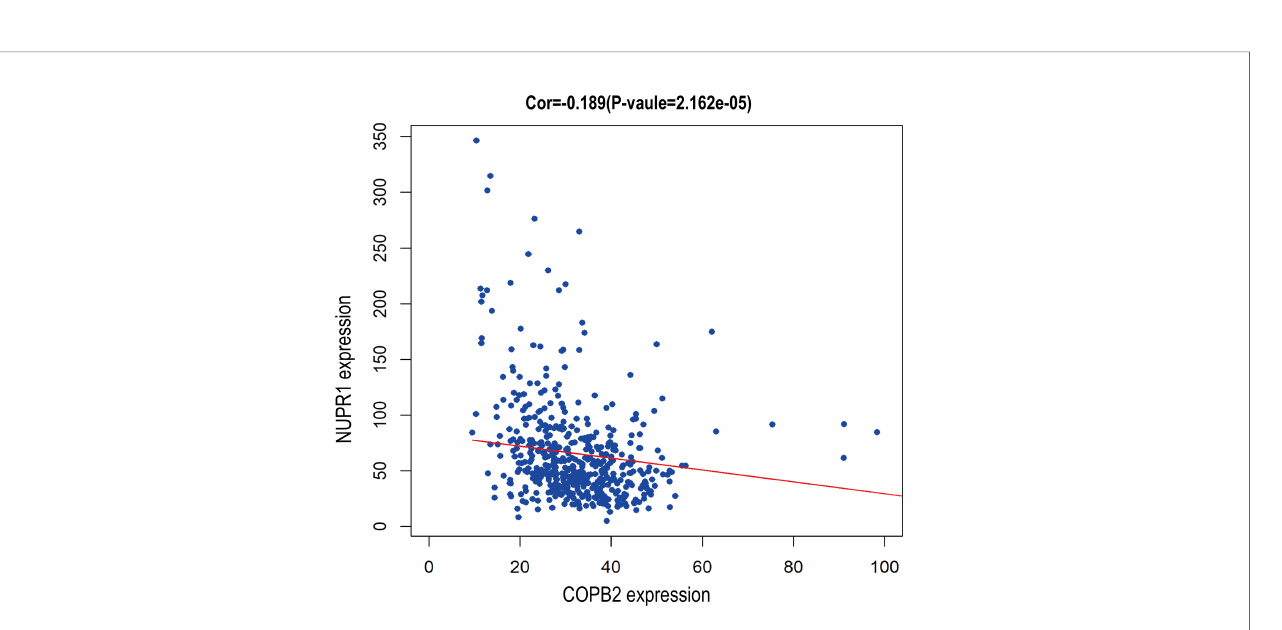
FIGURE 9 | Bioassay showed negative correlation between COPB2 and NUPR1